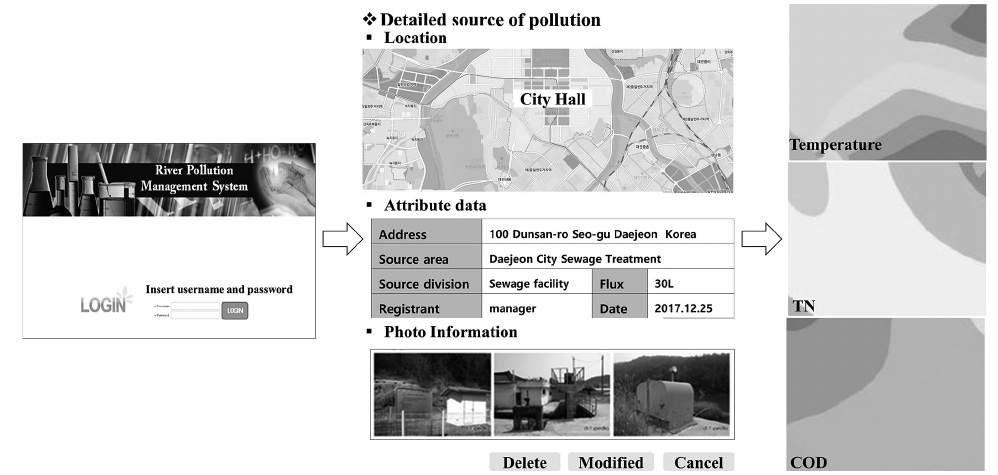
Figure 6. The web based reactive pollution management system showing the login interface, then single point details and attribute raster overlay in Daum satellite view map